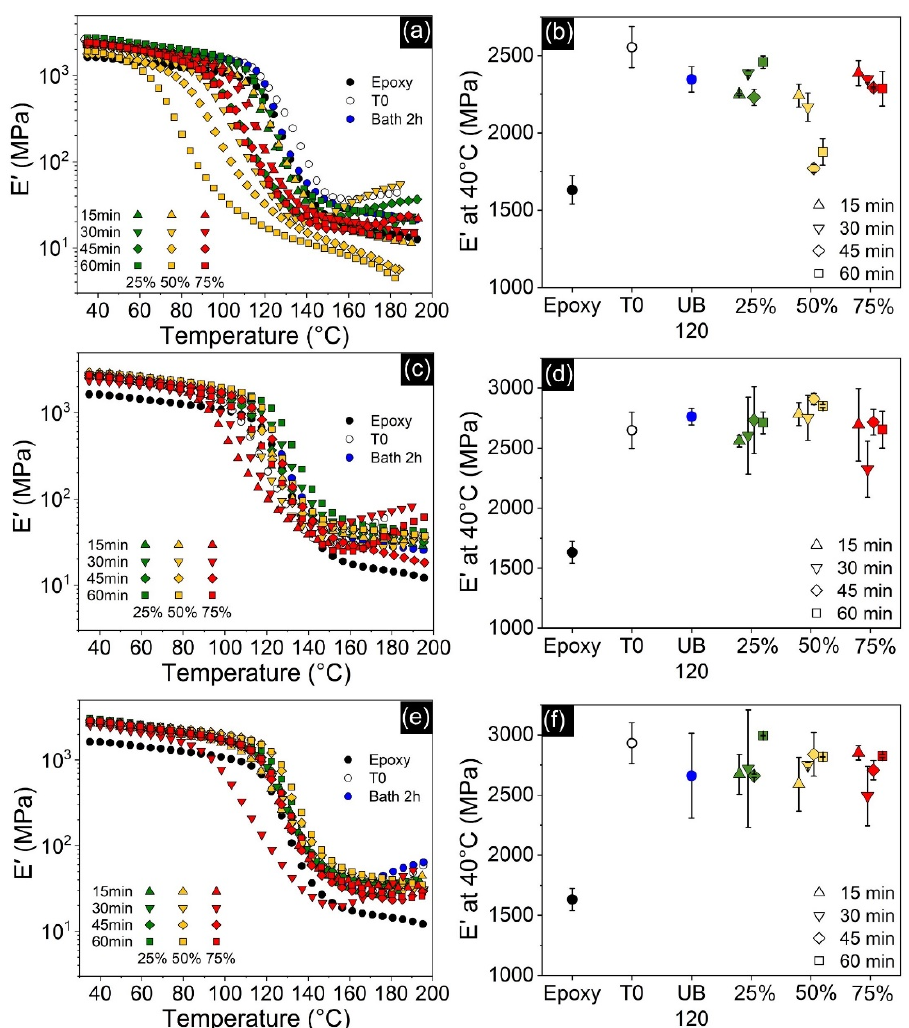
Figure 13. E’ curves (left) and E’ at the glassy state (right) for all nanocomposites compared to neat epoxy and as functions of processing methods. CNT-filled at the top ( a , b ); GNP-filled in the middle ( c , d ); and hybrid-filled nanocomposites at the bottom ( e , f ). T0 denotes the unprocessed samples and UB 120 the samples processed in the ultrasonic bath.